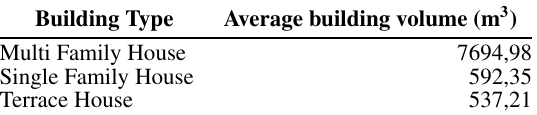
Table 2. Average volume of the three building typologies in the study